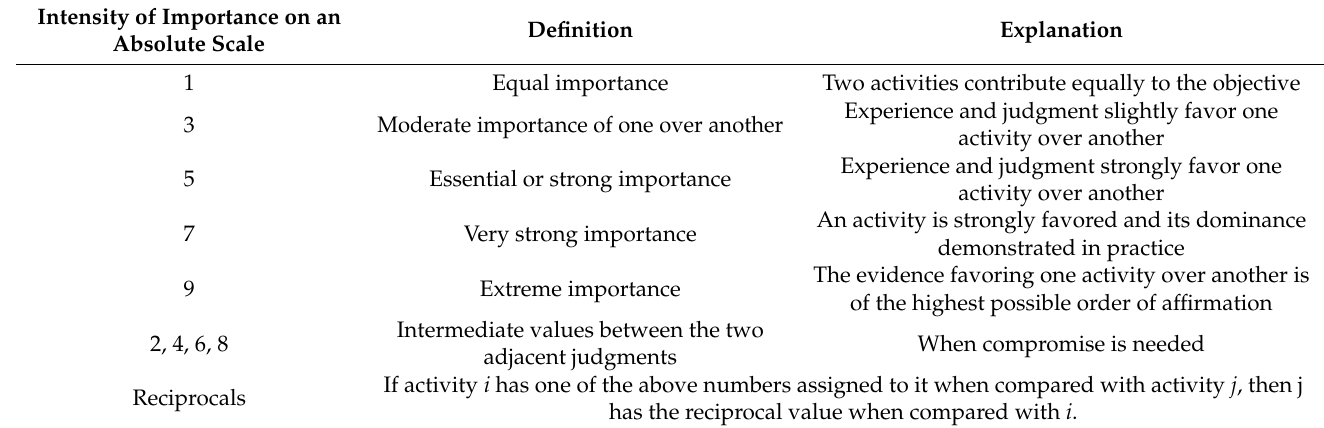
Table 2. Descriptive explanation of the AHP pair-wise comparison scale